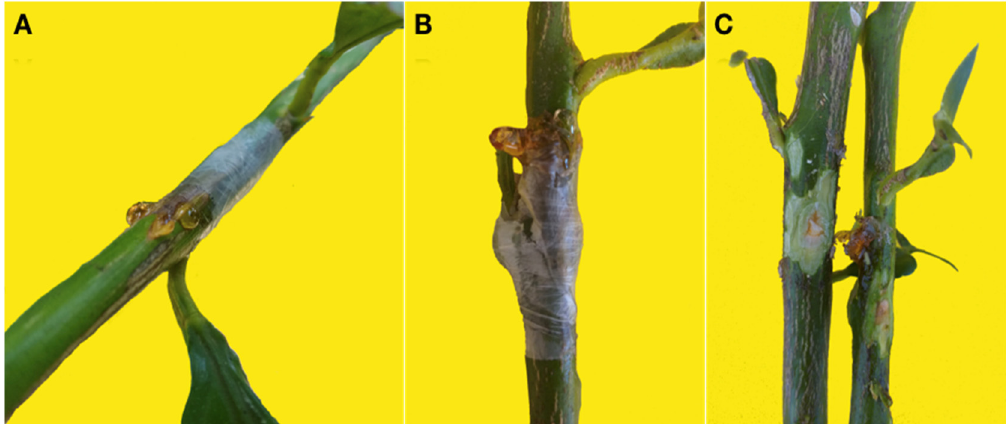
Figure 6. ( A ) Gumming on a twig of lemon “Femminello 2Kr” wound inoculated with a Colletotrichum gloeosporioides isolate 14 d.p.i. ( B ) Gumming on a twig of bergamot “Fantastico” wound inoculated with a Colletotrichum gloeosporioides isolate 14 d.p.i. ( C ) Twigs of bergamot “Fantastico” wound inoculated with Colletotrichum karstii (left) and C. gloeosprioides (right) 14 d.p.i. The bark was removed to show the internal symptoms: the twig on the left shows a gum impregnation of the young xylem and a cicatricial tissue around the inoculation point while the twig on the right shows a profuse gumming extending beyond the inoculation point.